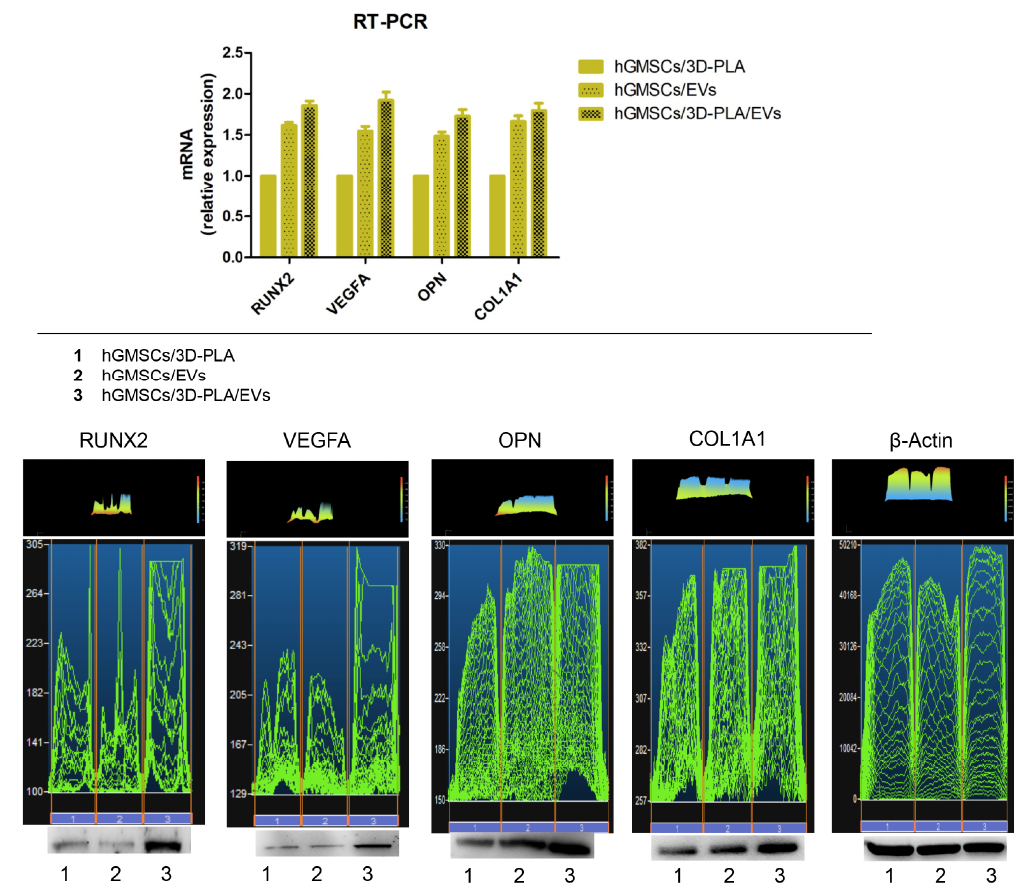
Figure 3. RUNX2 and VEGF expression. RT-PCR showed the different mRNA expression in hGMSCs/3D-PLA, hGMSCs/EVs and hGMSCs/3D-PLA/EVs. Western blot analysis of protein expression: RUNX2, VEGFA, OPN and COL1A1. * p < 0.05. Original figure published in: Pizzicannella J. et al [53].